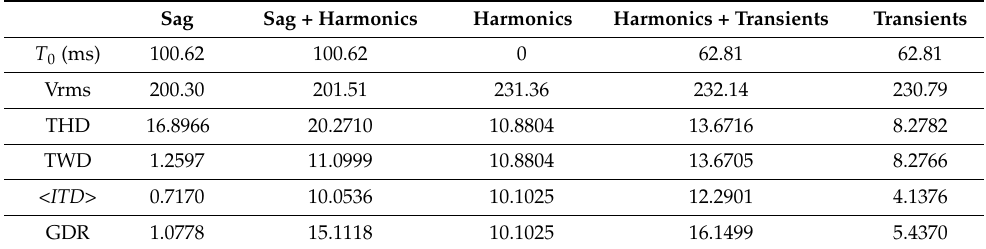
Table 5. Summary of Power Quality Indices for case